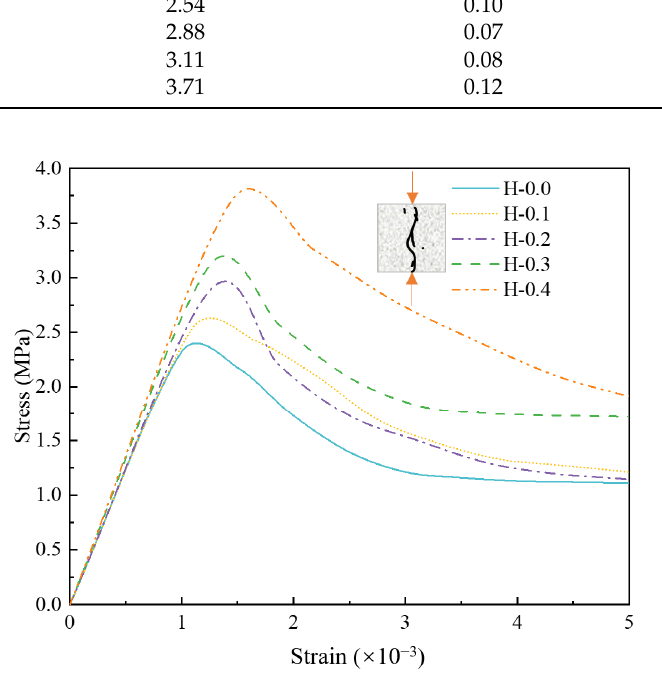
Figure 29. Numerical simulation of splitting tensile stress ‐ strain curve of hybrid fiber ‐ reinforced